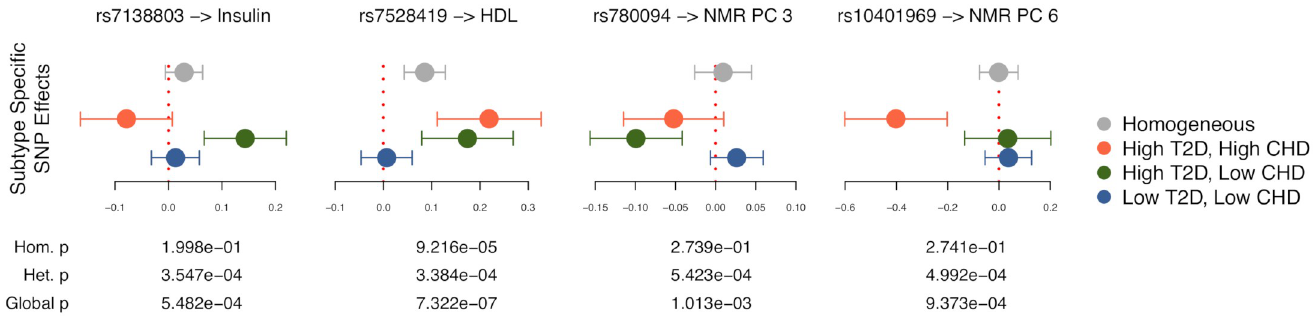
Fig 4. Metabolic subtype-specific SNP effects across the 16 traits used for subtyping. Subtype-specific effect estimates are shown ± 2 s.e. for significantly heterogeneous SNPs out of 81 known metabolic SNPs ( p = .05/81).